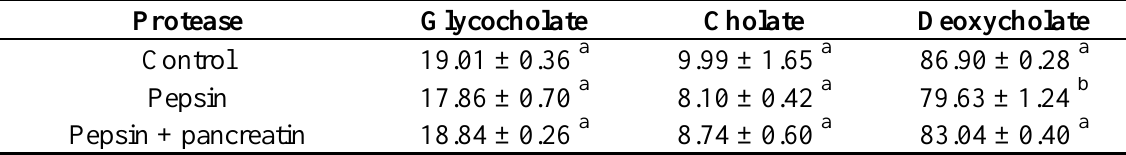
Table 1. Bile acid binding capacity after digestion by gastrointestinal proteases.